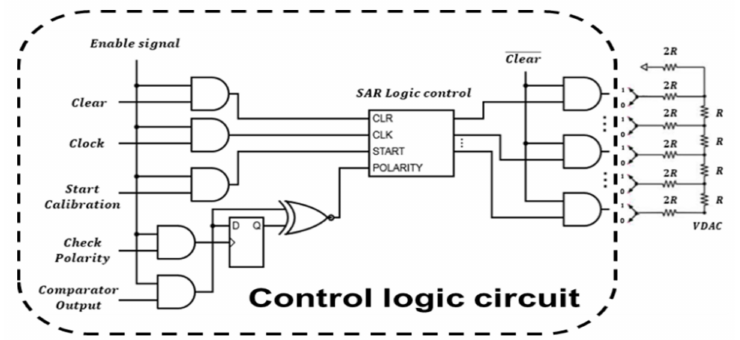
Figure 14. Calibration logic